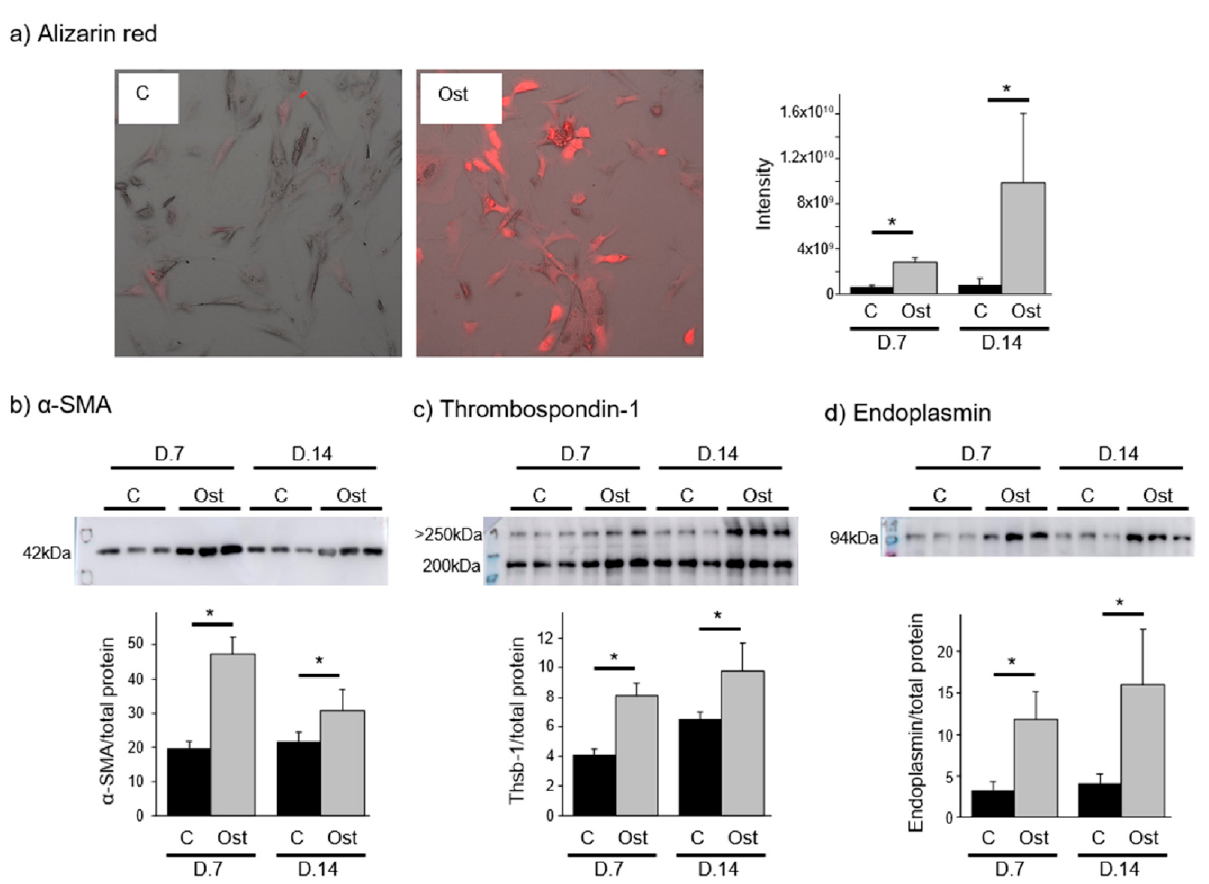
Figure 2. Verification of the osteoblastic differentiation through alizarin red staining ( a ) and α -SMA ( b ) and Western blot confirmation of thrombospondin-1 ( c ) and endoplasmin ( d ) levels in HAVICs treated with FIB medium (C) and osteogenic medium (Ost) after 7 and 14 days of culture. Data from western blots were normalized to total protein level (Ponceau S stain, Figure S1).*= p < 0.05.